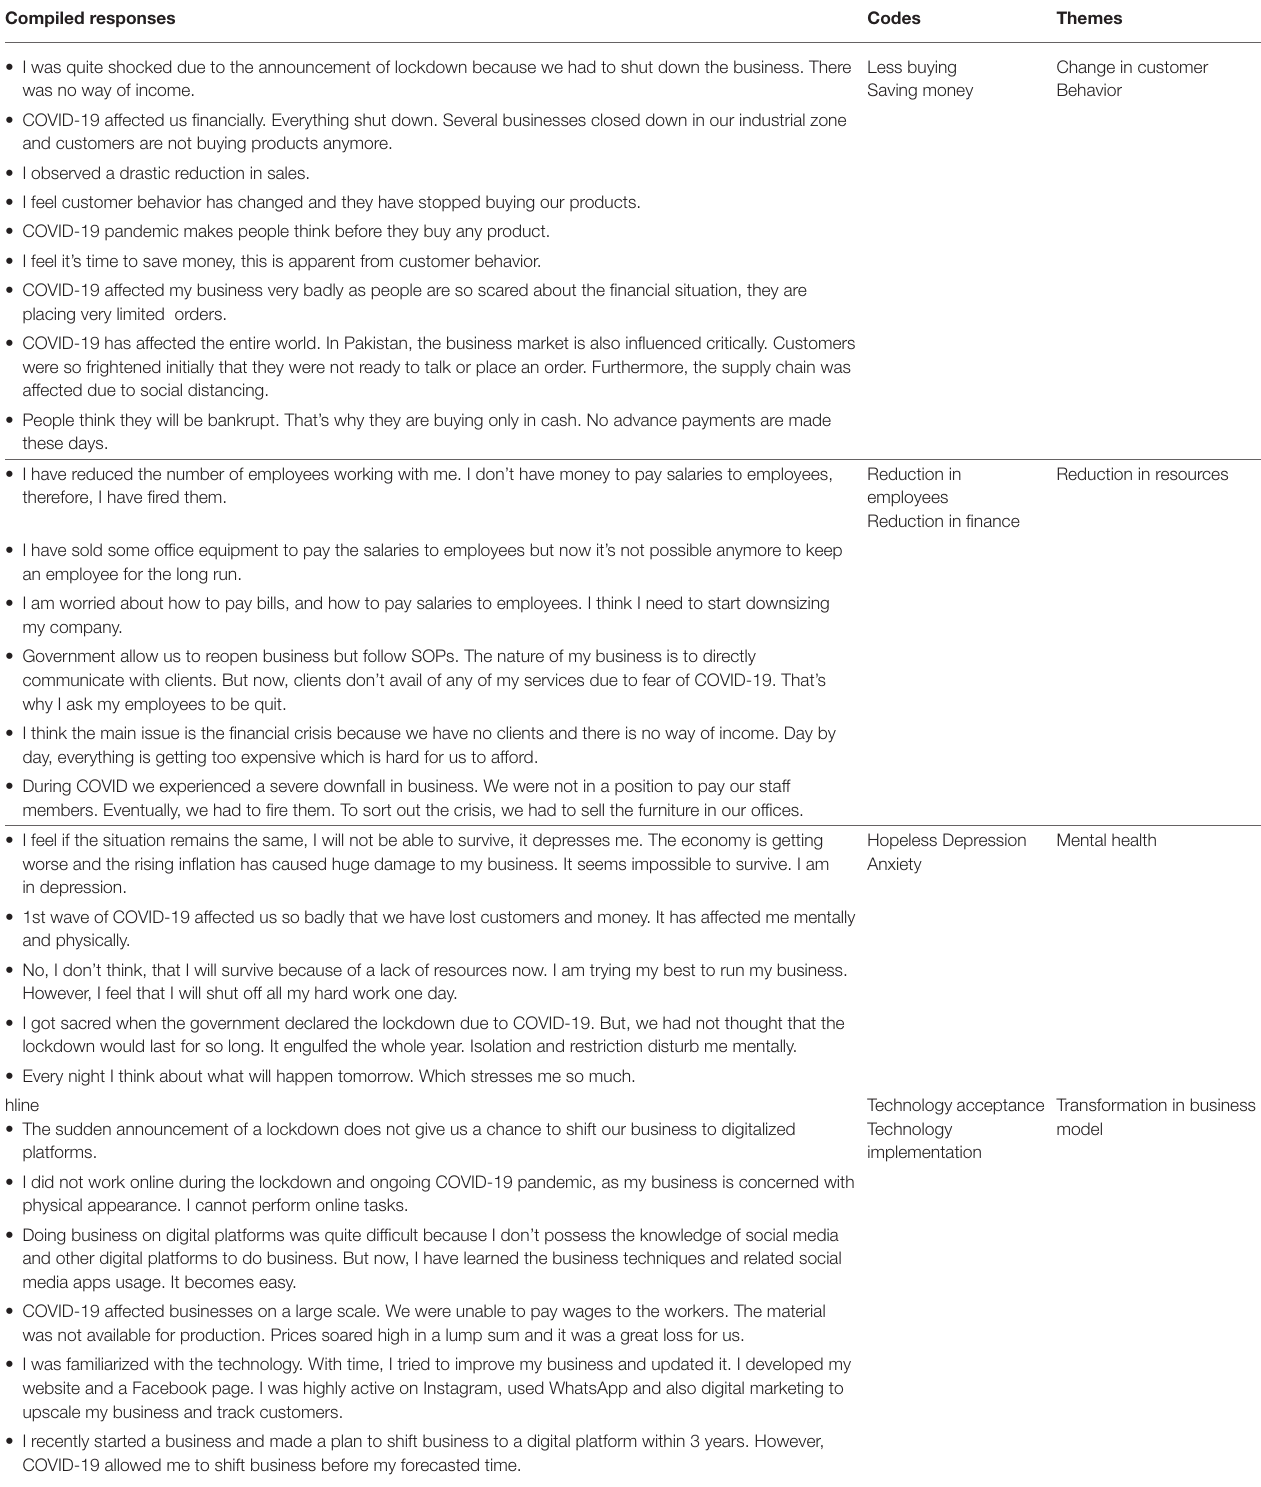
TABLE 3 | Coding and